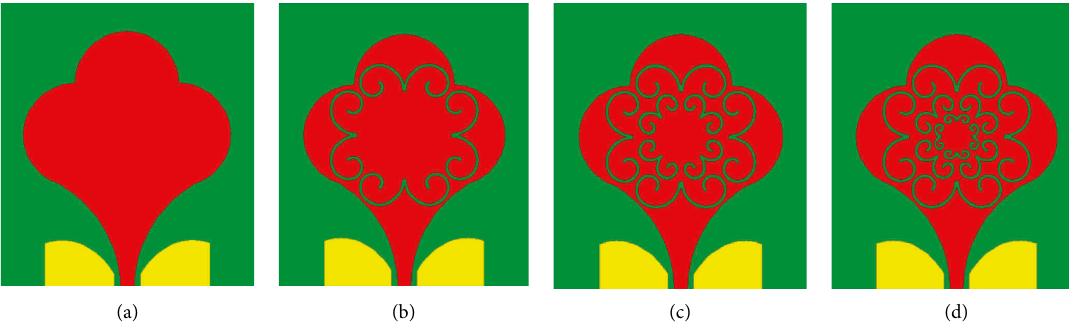
Figure 4: Iterative process of antenna: (a) 0 iterations, (b) 1st iteration, (c) 2nd iteration, and (d) 3rd iteration.